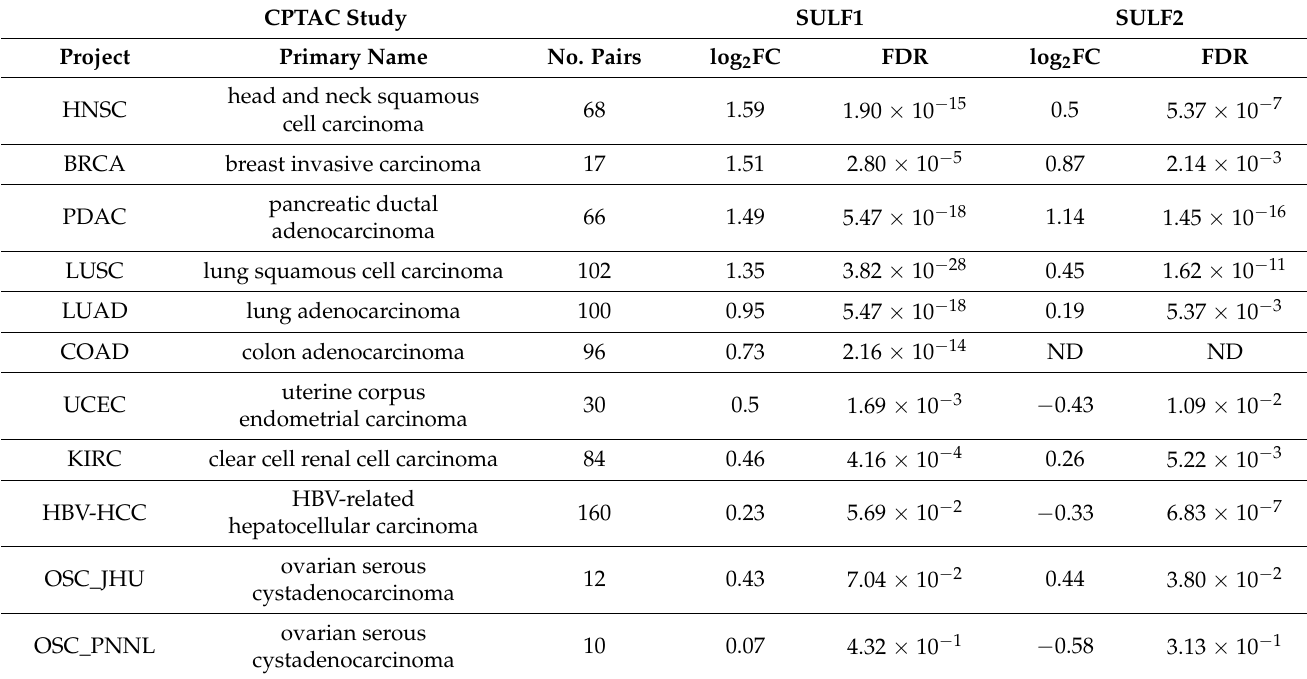
Table 2. Differential expression of SULF1 and SULF2 proteins between tumor and adjacent normal tissues in 10 CPTAC studies. Entries with |(log2FC)| > 1 and FDR < 0.05 are in bold. ND, not detected. CPTAC Study SULF1